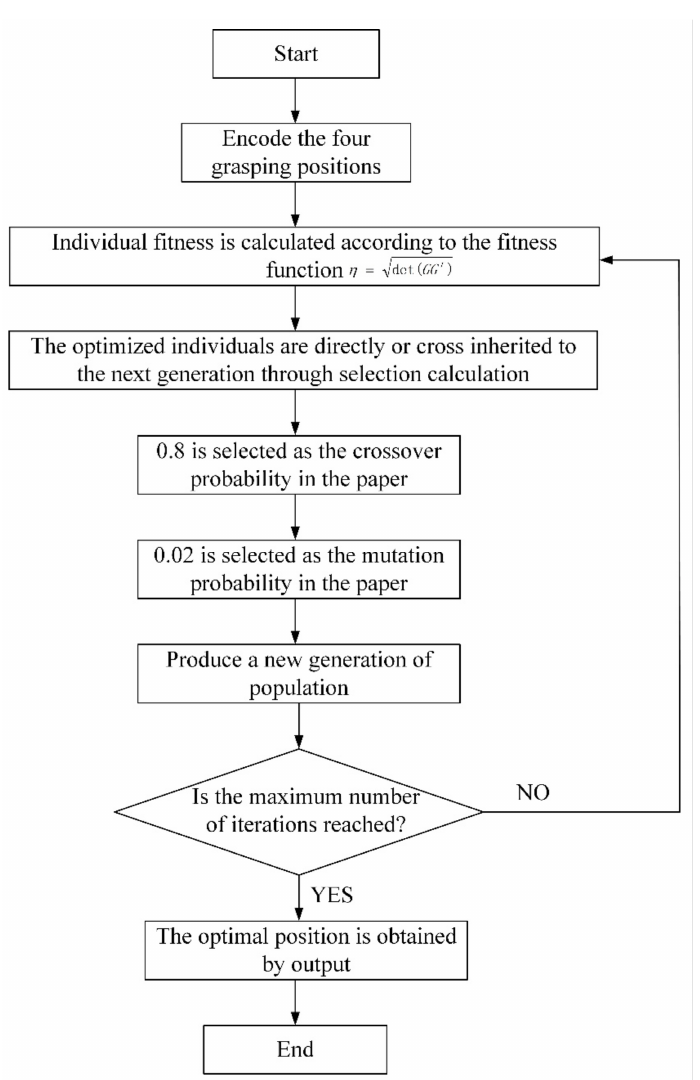
Figure 7. Flow chart of the genetic algorithm for detecting optimal grasping